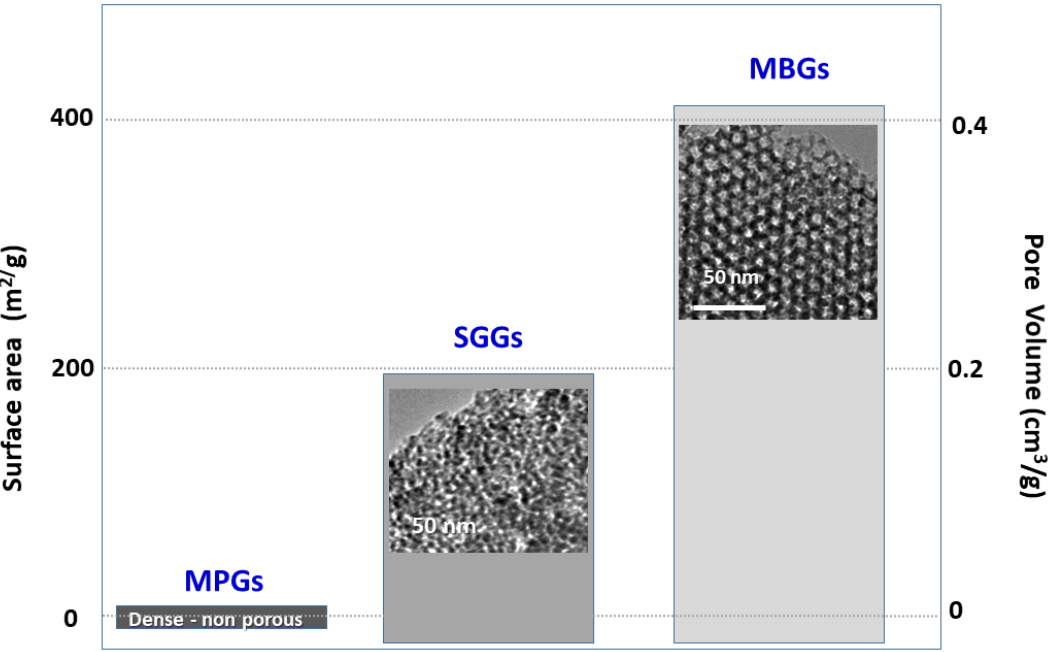
Figure 2. Textural properties of the three families of bioactive glasses. Transmission Electron Micro- graphs of the porous SGG and MBG are also included.